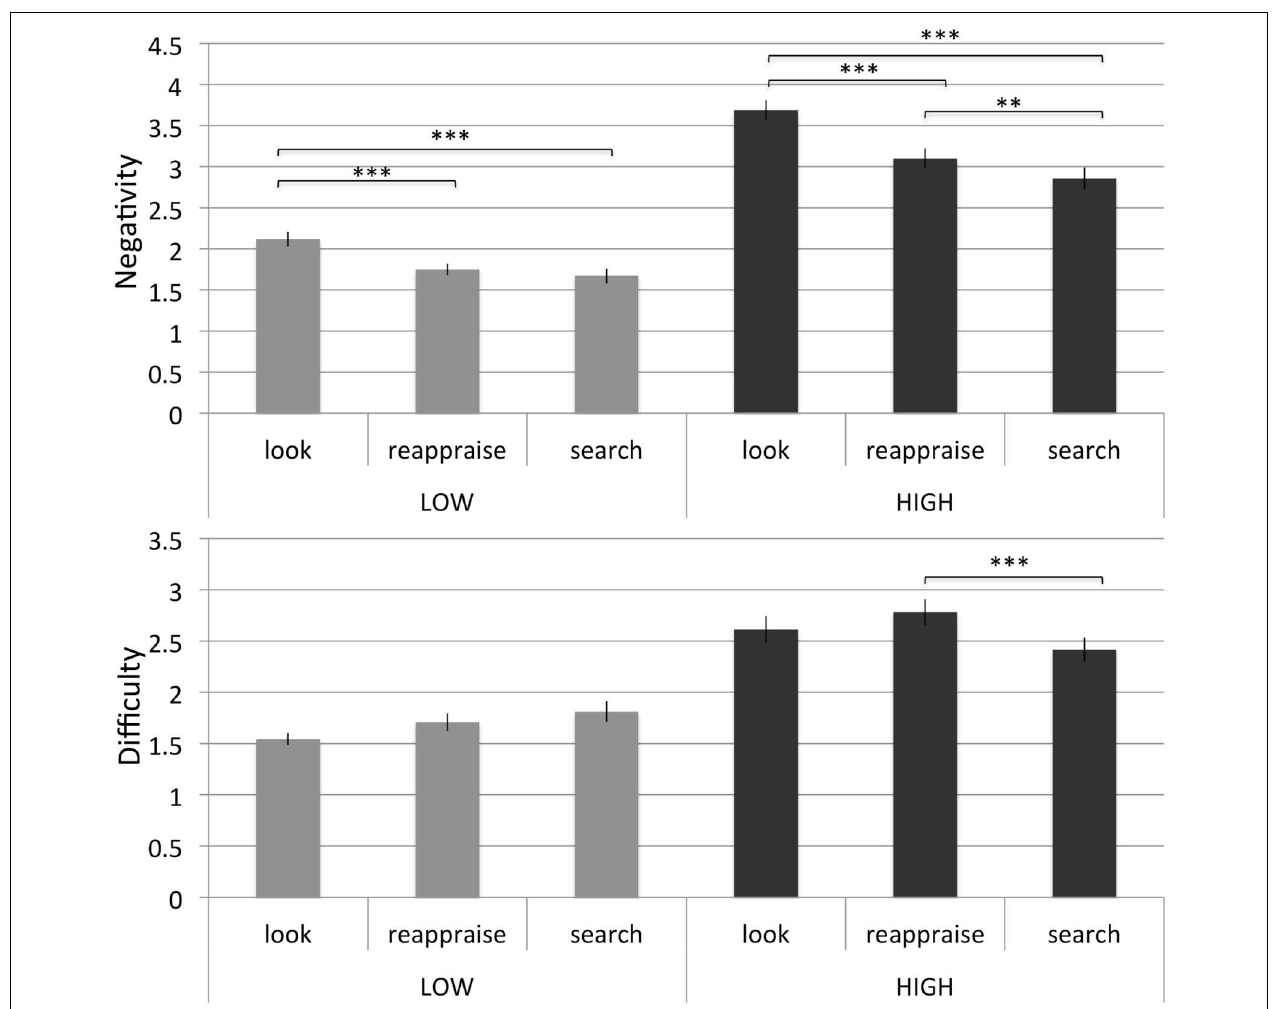
FIGURE 3 | Study 2: mean of negativity and difficulty ratings in low and high negative pictures in the three conditions (“look,”“reappraise,” and “search”), N = 44. *p < 0.05, ** p < 0.01, *** p < 0.001.